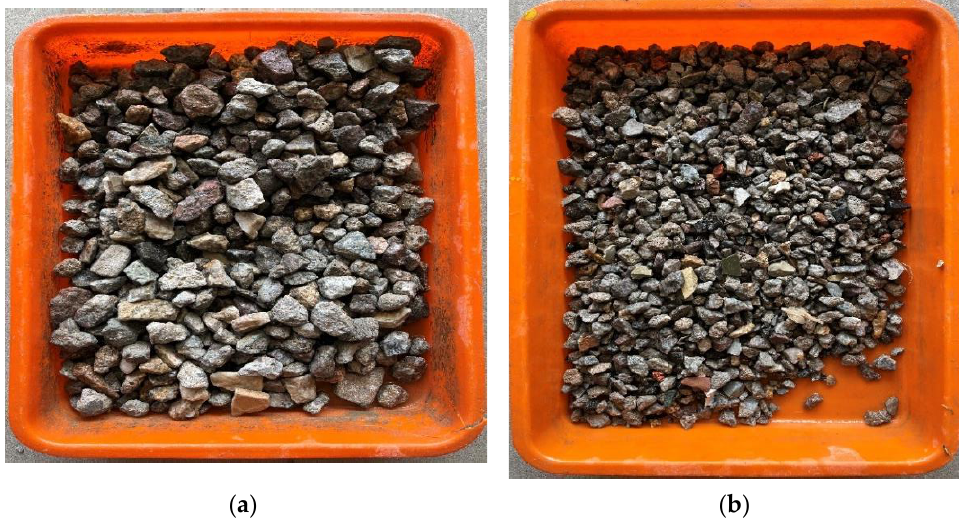
Figure 1. Coarse aggregates: ( a ) mixed coarse recycled aggregate (20 mm maximum size); ( b ) mixed coarse recycled aggregates (12 mm maximum